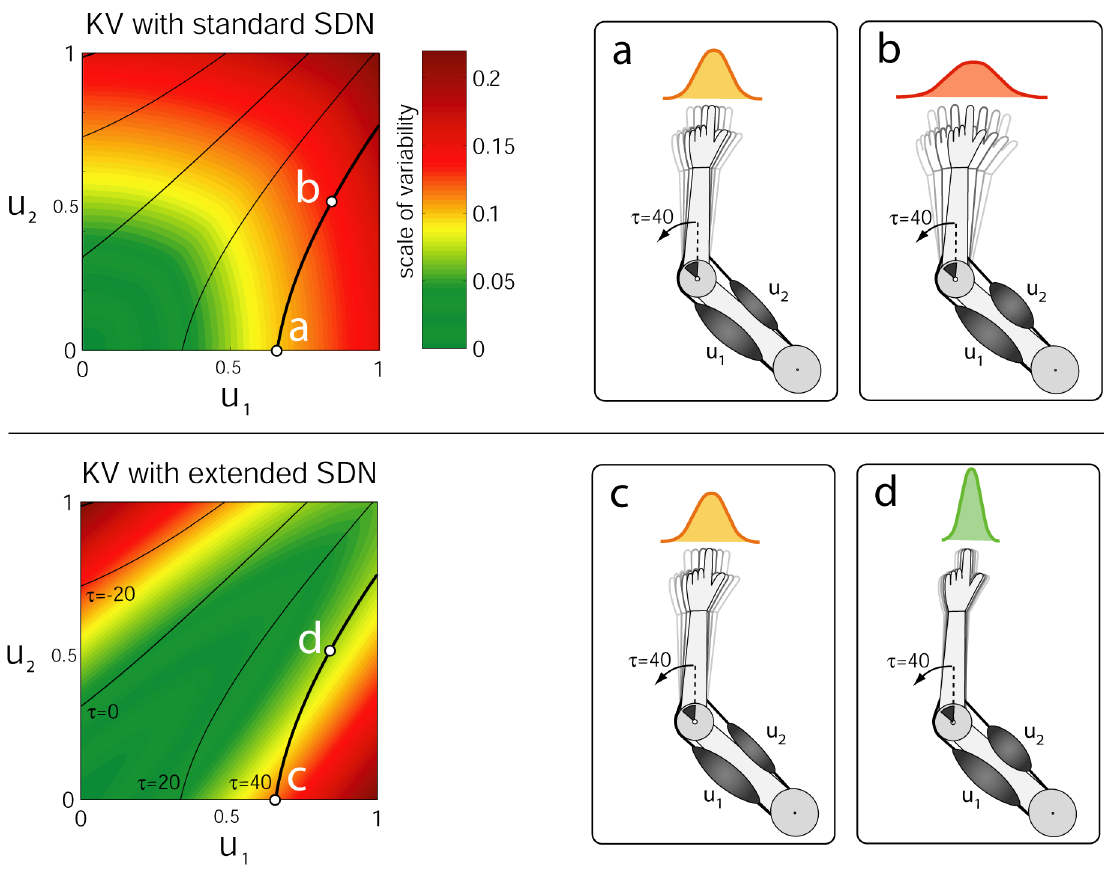
Figure 2. Illustration of the effects of standard and extended SDN on kinematic variability in the end-effector. Standard SDN scales proportionally to the muscle activation, whereas the extended SDN takes into account the stabilizing effects of higher joint impedance when co- contracting (see Methods), producing a ‘‘valley of reduced SDN’’ along the co-contraction line u 1 ~ u 2 . The colors represent the noise variance as a function of muscle activations, whereas the dark lines represent muscle activations that exert the same joint torque computed for joint angle position q ~ p = 4 . (a) Only muscle u 1 is activated, producing t ~ 40 Nm joint torque with a Gaussian kinematic variability of N (0,0 : 1) . (b) The same torque with higher co-contraction produces significantly higher kinematic variability of N (0,0 : 15) under standard SDN. (c) Same conditions as in (a) in the case where only muscle u 1 is activated. In contrast to (b) the extended SDN in (d) favors co-contraction leading to smaller kinematic variability of N (0,0 : 05) and to more stable